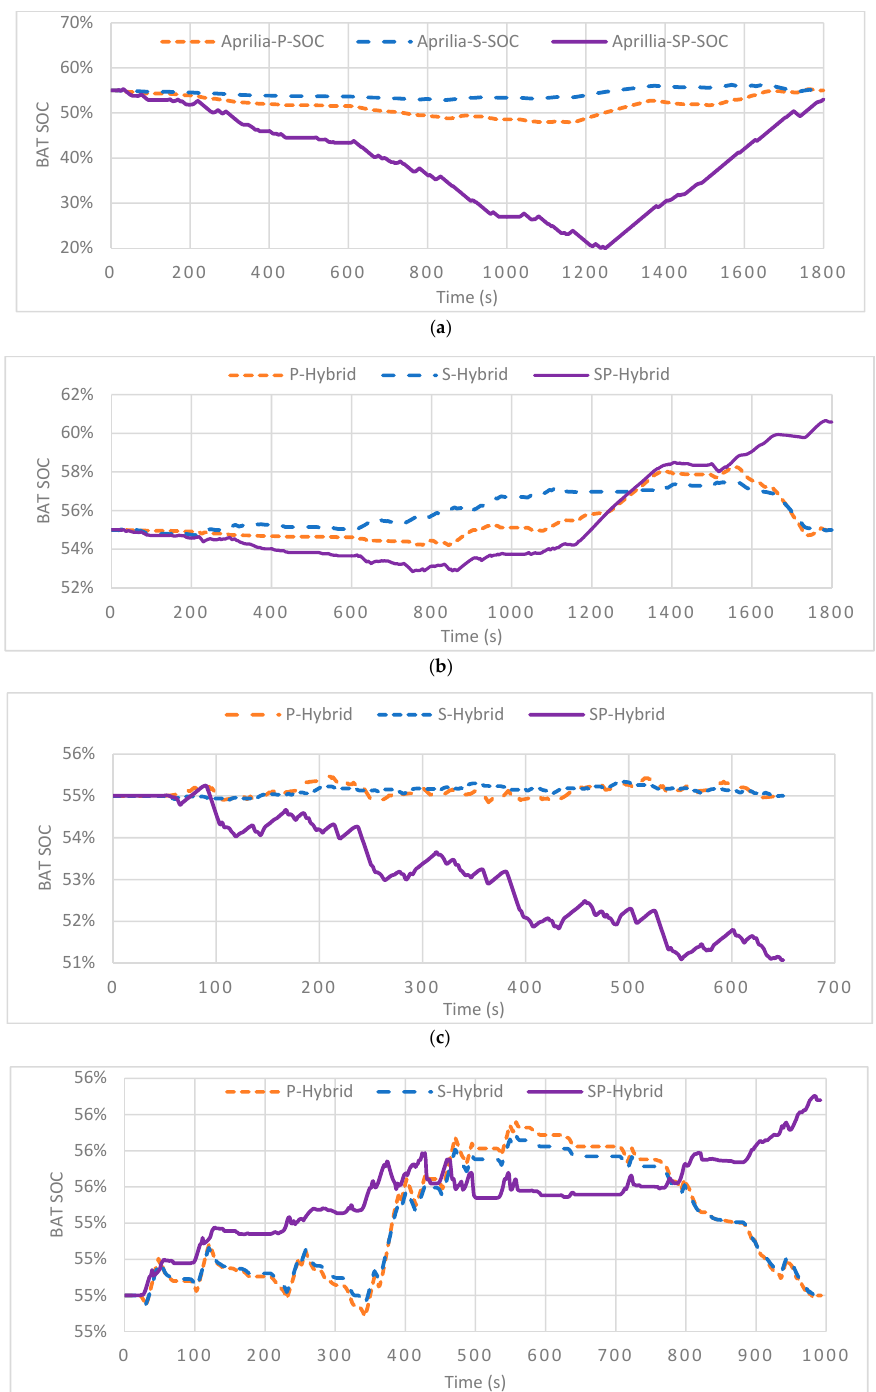
Figure 15. ICE power distribution for three architectures: ( a ) Aprillia in WLTP driving-cycle; ( b ) CT6 in WLTP driving-cycle; ( c ) Noao in Race way driving-cycle; and ( d ) K9 in Artemis Urban driving-cycle.